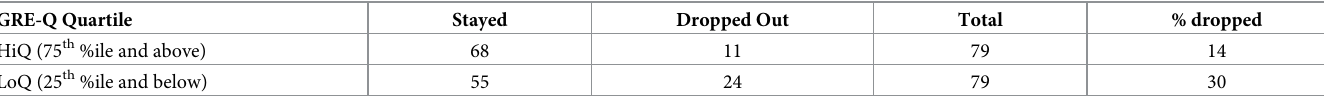
Table 1. Chemistry dropouts By GRE-Q quartile.